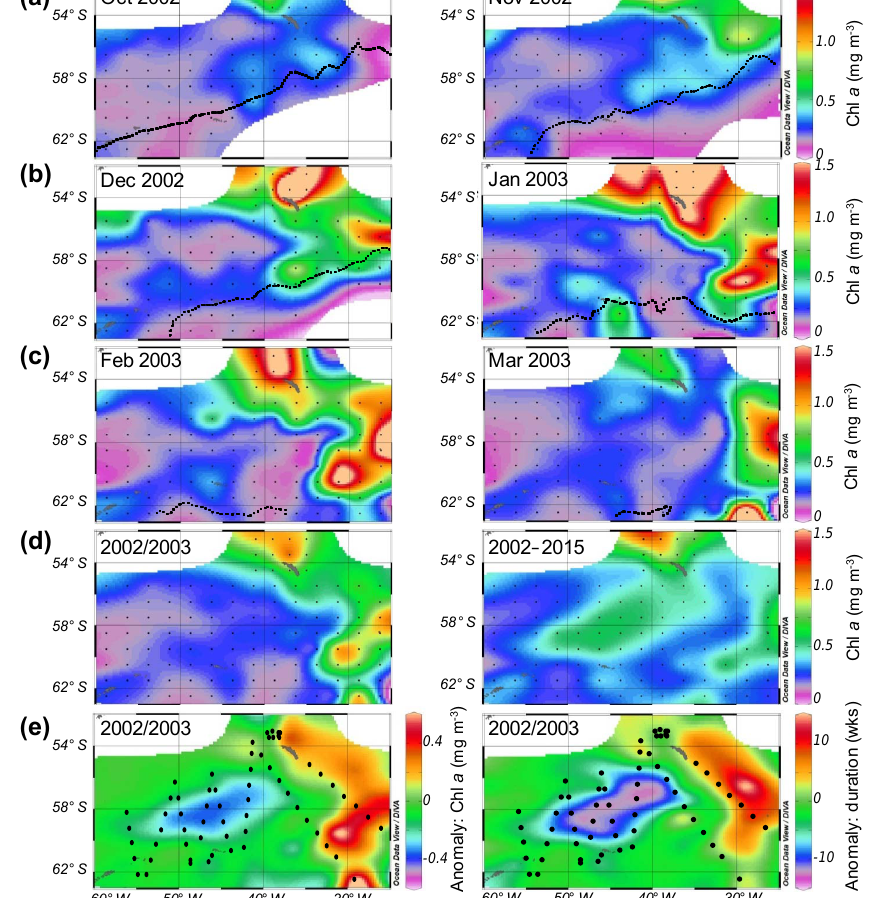
Figure 2. Phytoplankton bloom development in the Scotia Sea. Monthly mean chl a concentrations in 2002/2003; (a) the early season, (b) the mid-season, and (c) the late season. (d) Seasonal mean chl a concentrations (September–March) in 2002/2003 and over the 13-year average of 2002–2015. (e) Anomaly in seasonal mean chl a concentration (left) and bloom duration (right) for 2002/2003 compared to the 13-year average of 2002–2015. Chl a concentrations were derived from ocean colour radiometry (MODIS, 8-day composites, September–March). A bloom was defined as >0.5mgChl a m − 3 . The dashed line represents the mean position of the 15% ice edge during each of the months. In (e) , the position of our sampling stations is